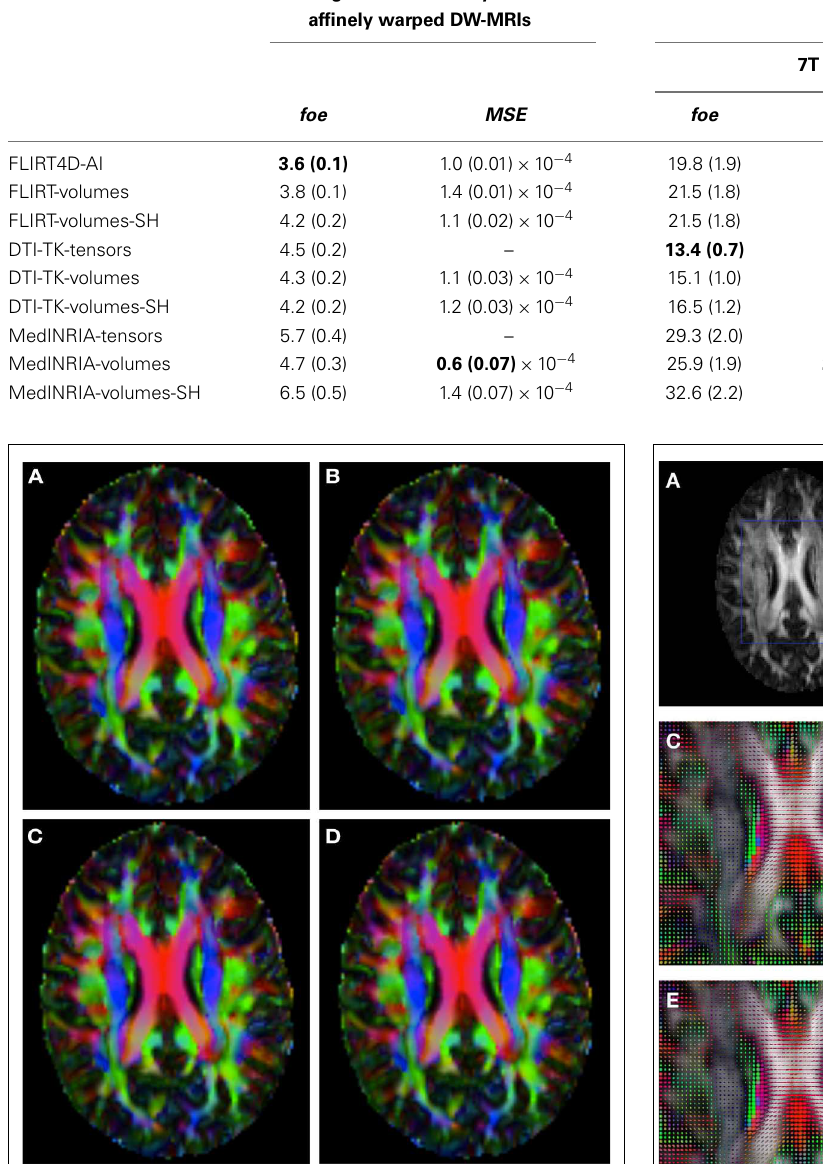
FIGURE 6 | Checkerboard comparison of the RGB color coded main diffusion direction between Subject2 and a registered random non-linear transformation of Subject2 using (A) FNIRT-volumes-SH. (B) FNIRT4D-AI. (C) MedINRIA-volumes-SH, (D) DTI-TK-volumes-SH. necessarilyimproveresults,andinfactcanincreasethe foe .Inaddi- tion, minimizing the MSE does not necessarily minimize the foe .